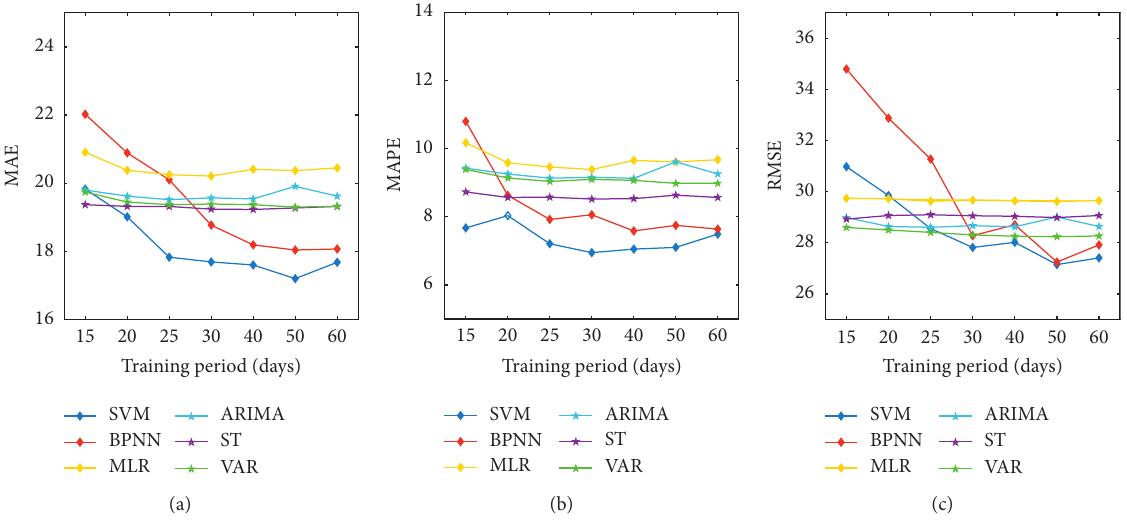
Figure 5: Comparison of training period for the different models. Table 1: MAE, MAPE, and RMSE of six models for different minutes ahead predictions with 5-minute as aggregating level. Time scale: